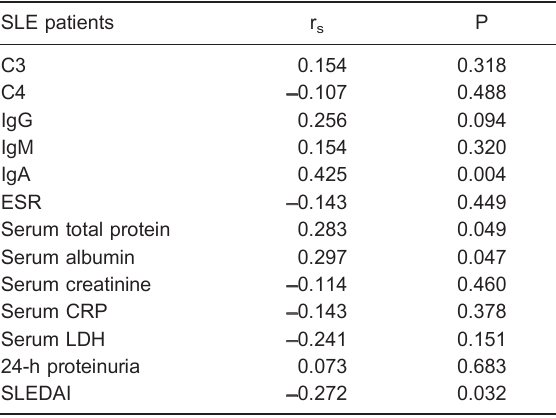
Table 2. Correlation between TIM-3 mRNA expression and clinical parameters in systemic lupus erythematosus (SLE)